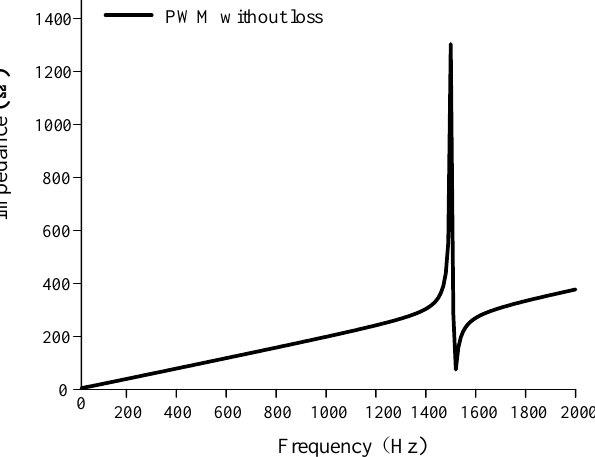
where R c is the resistance of the wound wire electric solenoid, and Z 0 = j ω L 0 . MATLAB is used to program and simulate Equation (9), and the calculated result of the transducer’s impedance without material losses is shown in Figure 7, which adopts the classic Terfenol-D material parameters as presented in [13].